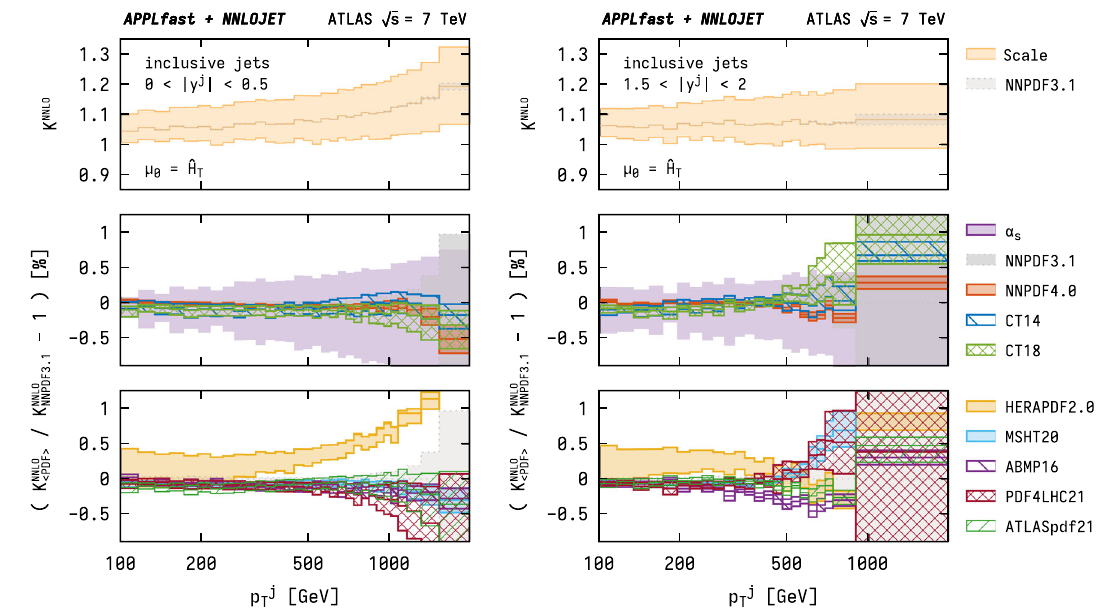
Fig. 5 Summary of studies of the NNLO K -factor for the ATLAS 7TeV inclusive jet cross section as a function of p jet tative ranges in rapidity. Top: the NNLO K -factor and corresponding